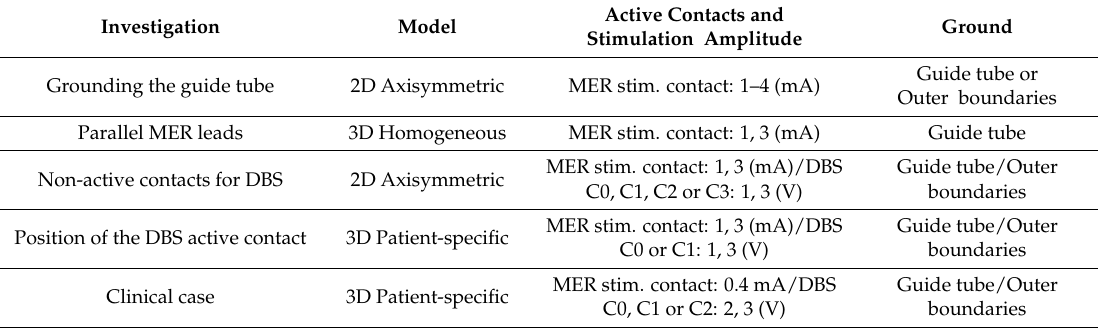
Table 1. Summary of the settings to investigate the EF due to differences between the MER stimulation and the DBS